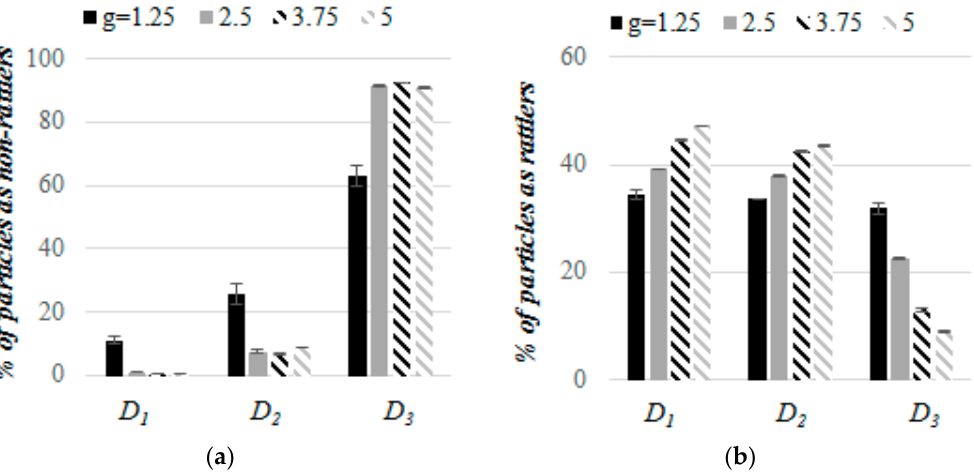
Figure 5. Percentage of the particles that are non-rattlers ( a ) and rattlers ( b ) in compressed mixtures with various values of g when subjected to a vertical load of 100 kPa.